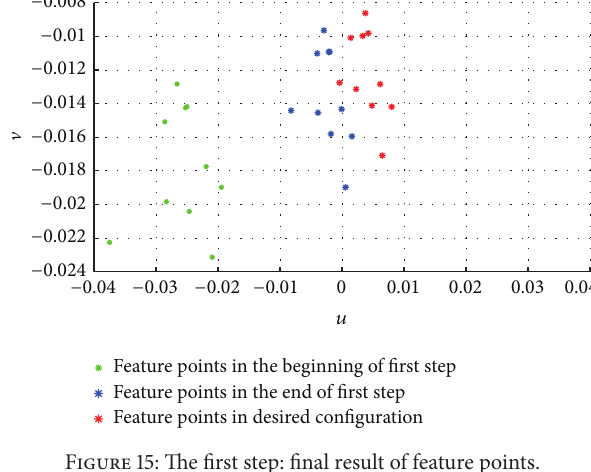
Figure 15: The first step: final result of feature points.